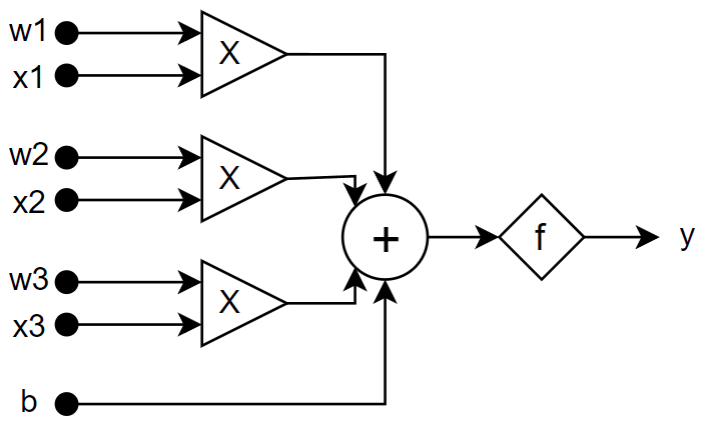
Figure 1. Artificial neuron with three inputs.